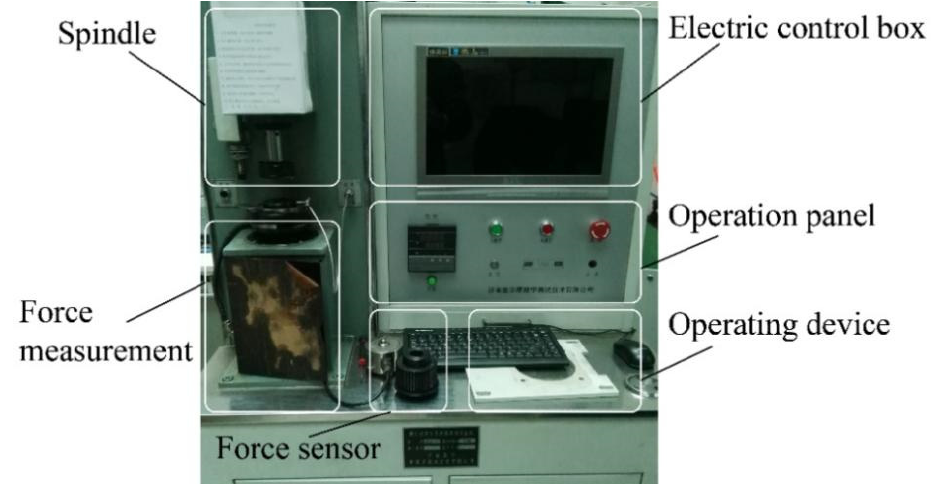
Figure 11. Pin-on-disc wear experimental machine. The pin-on-disc wear experiment adopts the sample pin and the sample disc